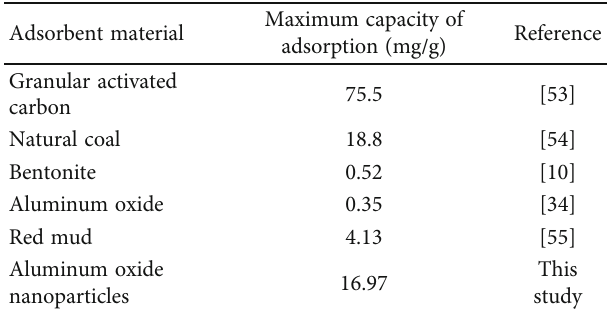
Figure 6: Isotherms: (a) Langmuir, (b) Freundlich, (c) Dubinin-Radushkevich, and (d) Temkin. Table 1: Comparison of the maximum capacities of the adsorption of phenol onto di ff erent